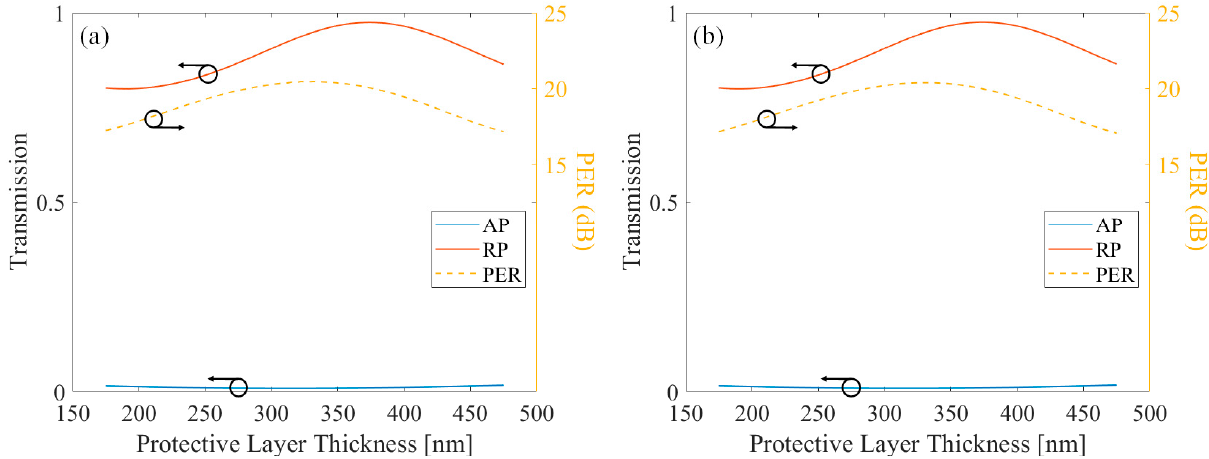
Figure 6. The AP component transmission, RP component transmission, and their PER of the protective layer applied MSCRA in terms of protective layer thickness. The direction of the light is ( a ) Substrate to free-space and ( b ) Free-space to substrate.